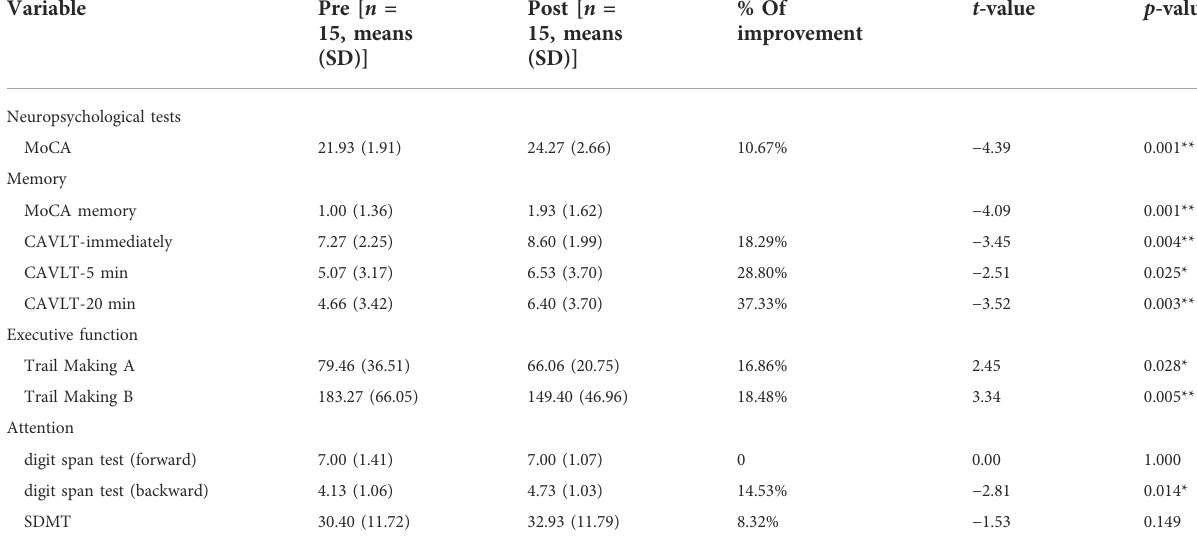
TABLE 2 Improvement in cognitive function after dual-target rTMS in MCI patients.